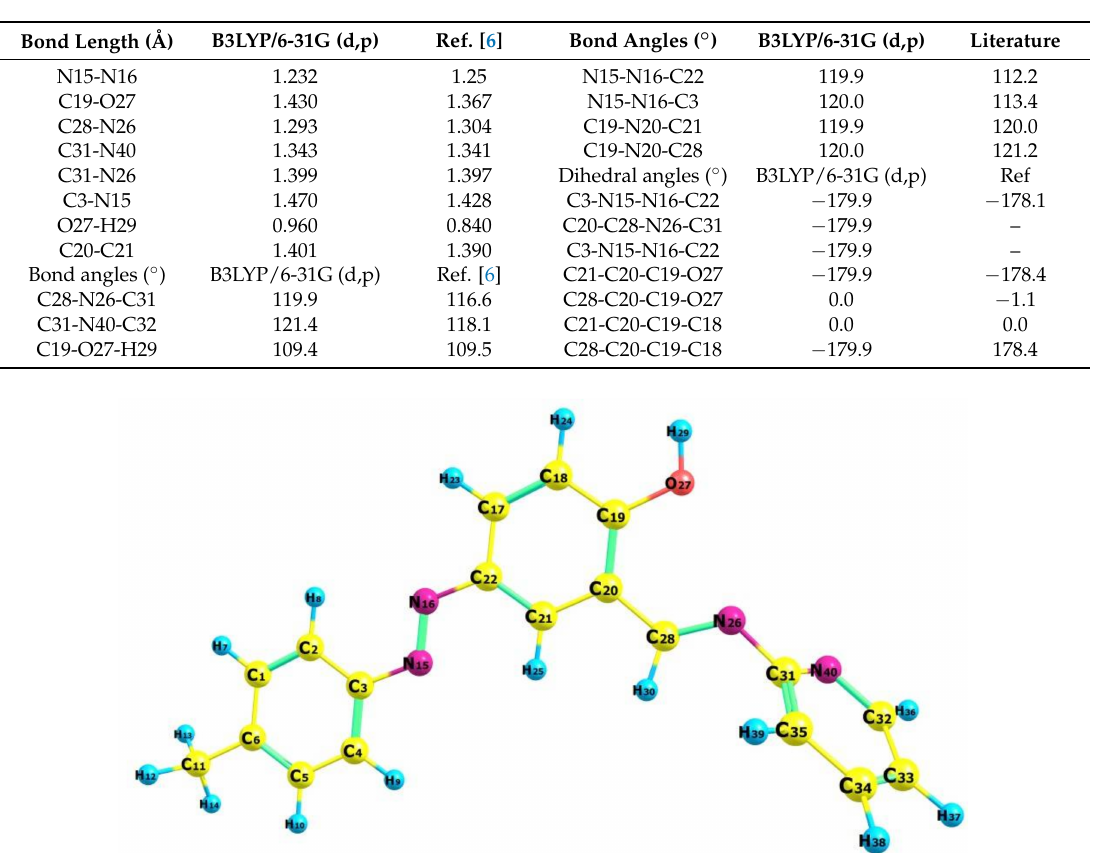
Table 2. Selected Optimized geometrical parameters of ligand in the ground state.